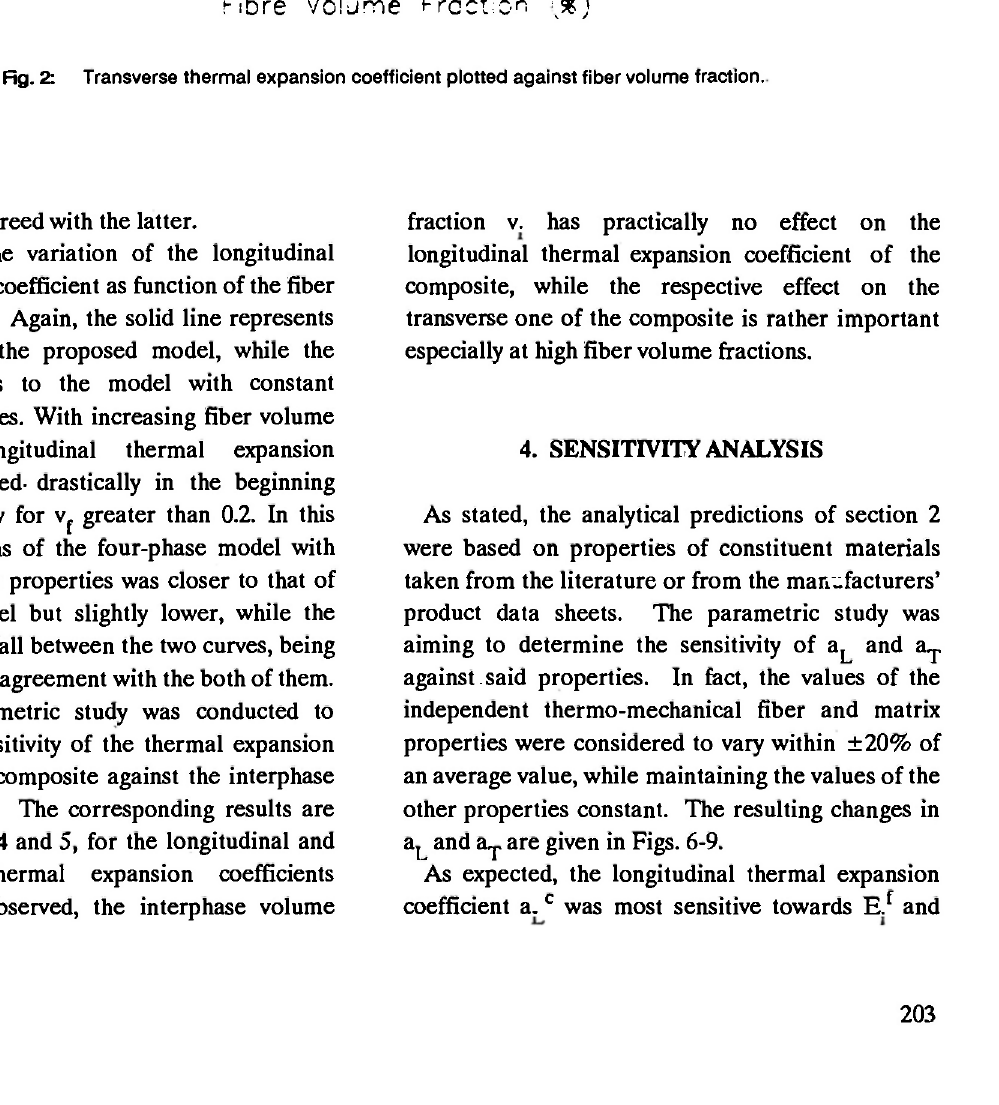
Fig. 2: Transverse thermal expansion coefficient plotted against fiber volume